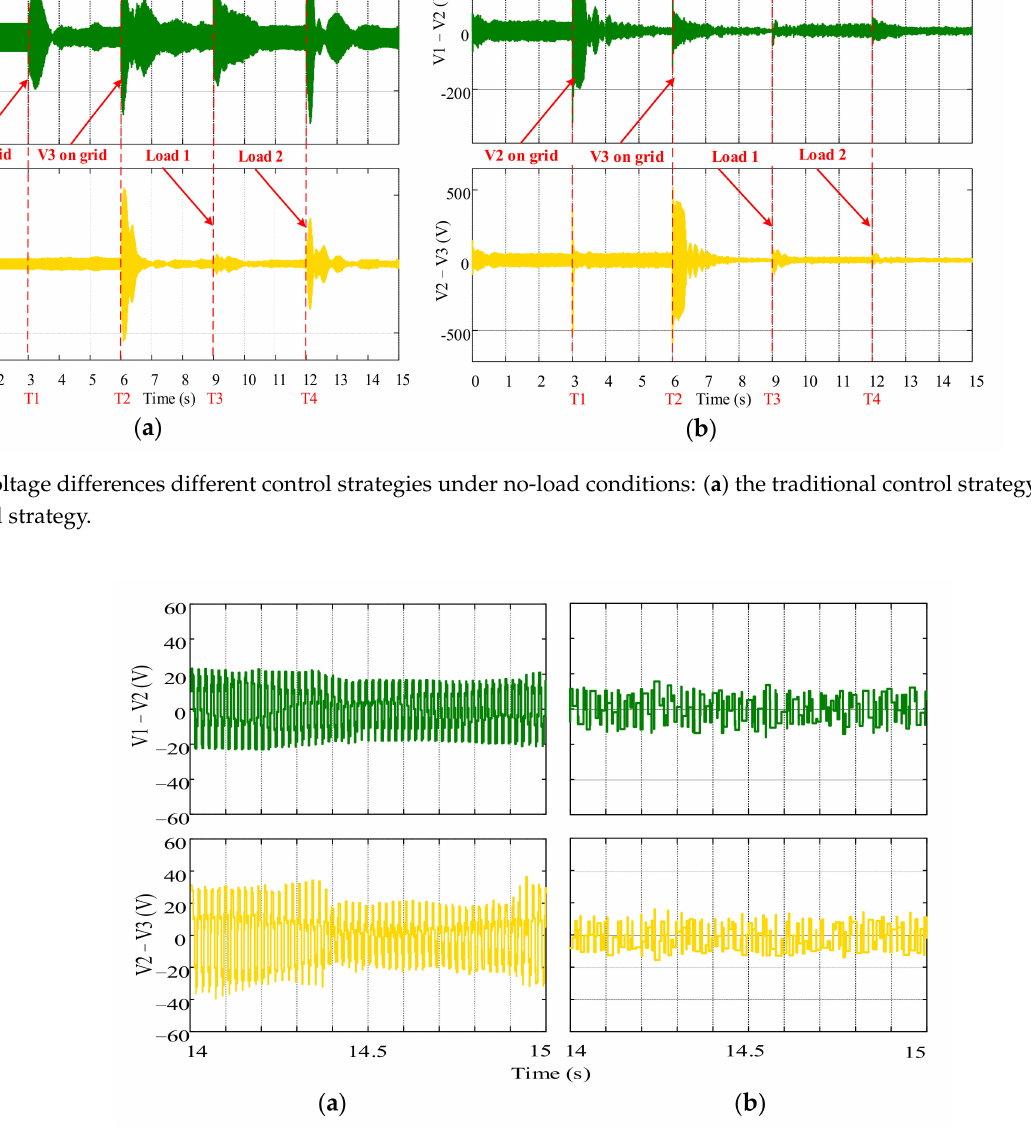
Figure 8. The zoomed-in voltage differences in the steady state under a no-load condition: ( a ) the traditional control strategy; ( b ) the proposed